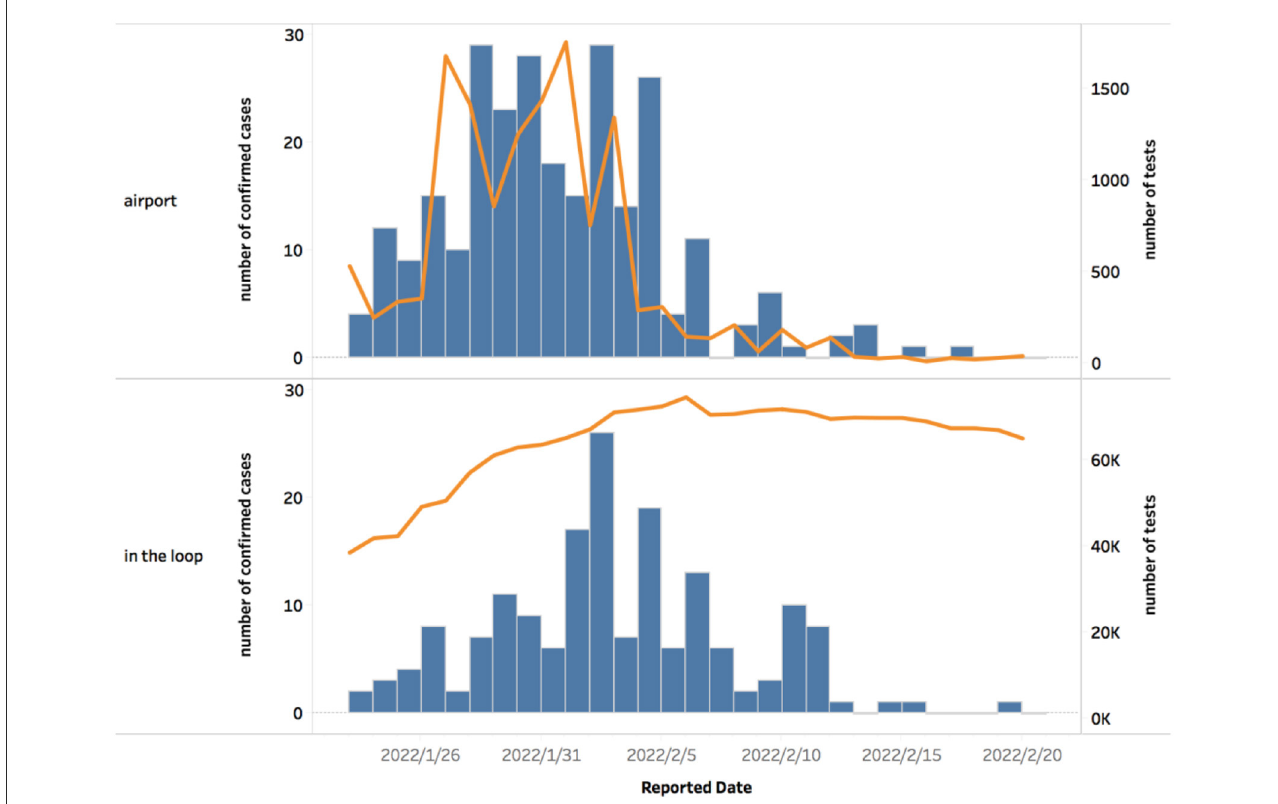
FIGURE1 The number of confirmed positive cases and screening tests performed during the Beijing 2022 Olympic Winter Games. This figure depicts the changing patterns in daily reported positive cases and the number of nucleic acid tests performed from 23rd January 2022 to 20th February 2022. The histogram represents the number of daily reported cases while the line graph depicts the number of nucleic acid tests conducted per airport and within the loop. The number of reported cases from the airport went with the numbers of tests conducted, namely the numbers of entry personnel. Since 3rd February 2022, the number of tests conducted in the loop stayed at around 70,000.